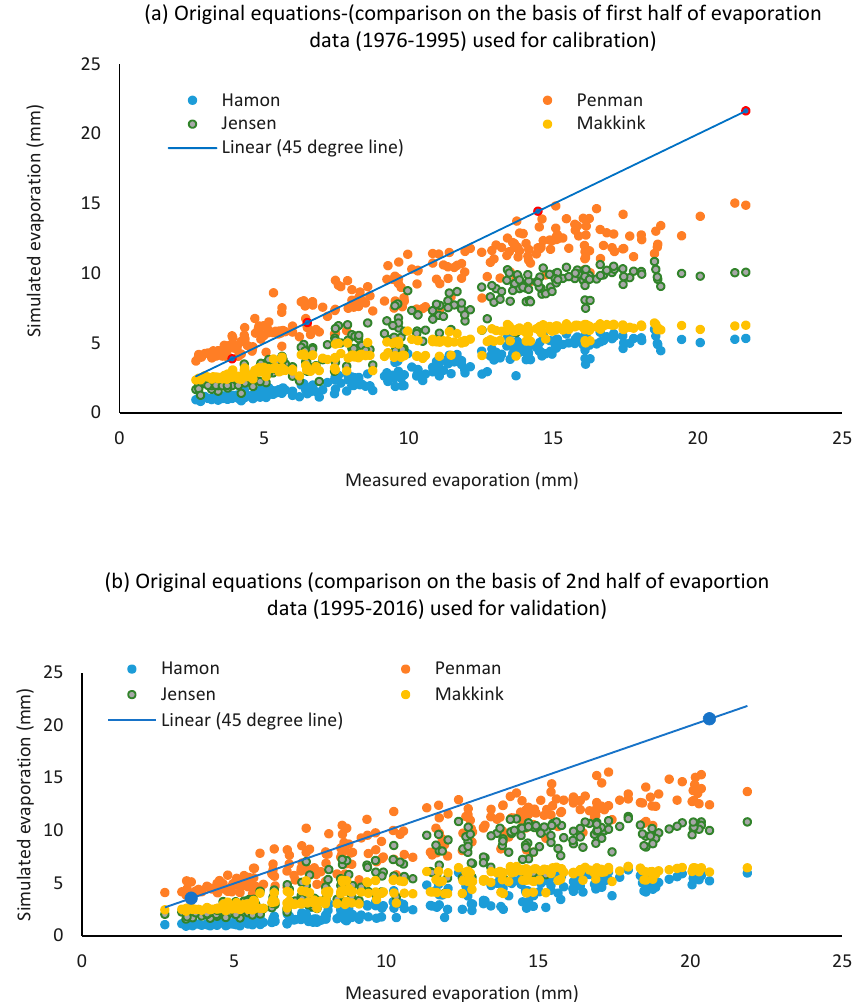
Figure 5. Comparison of the observed and simulated values of evaporation obtained from the four equations: ( a ) Original equations—half data; and ( b ) original equations—second half data.